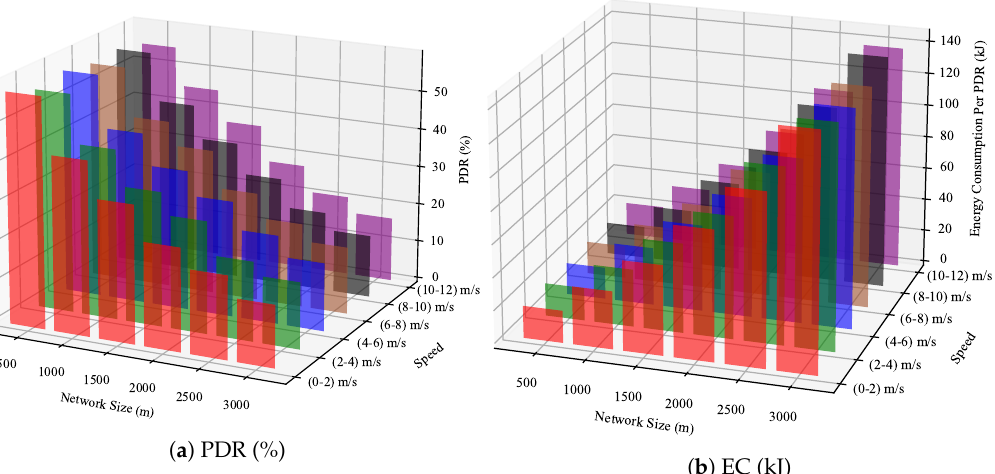
Figure 12. PDR & EC of the LP-MAB scheme versus varying network sizes and different mobility speeds in Scenario 5.